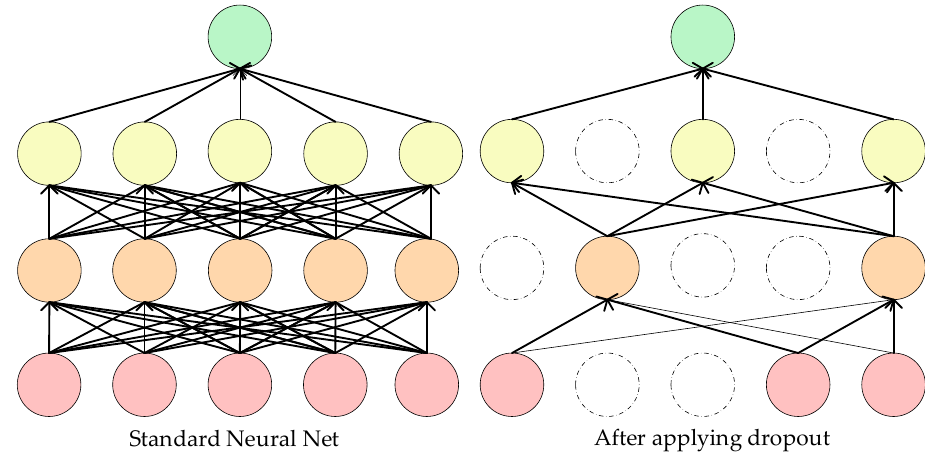
Figure 2. Dropout abridged general view.